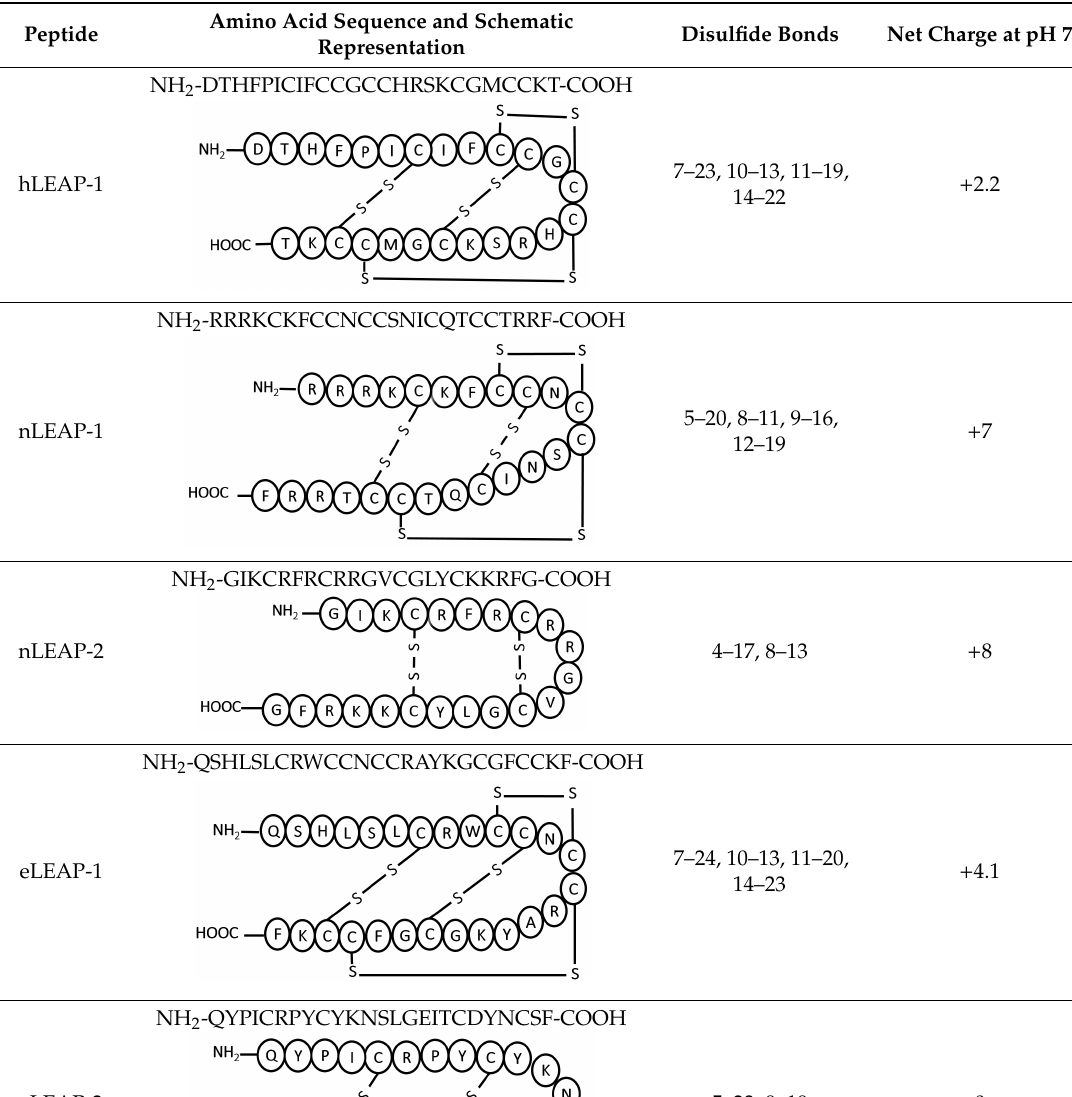
Table 1. Liver-expressed antimicrobial peptides (LEAPs): the amino acid sequence and schematic representation of hLEAP-1 (Human liver-expressed antimicrobial peptide), nLEAP-1 and nLEAP-2 (Antarctic notothenioid liver-expressed antimicrobial peptide: Dissostichus mawsoni ) and eLEAP-1 and eLEAP-2 (Antarctic Eelpout liver-expressed antimicrobial peptide: Lycodichthys dearborni ), their possible sites of disulfide bond formation and net charge at pH 7.